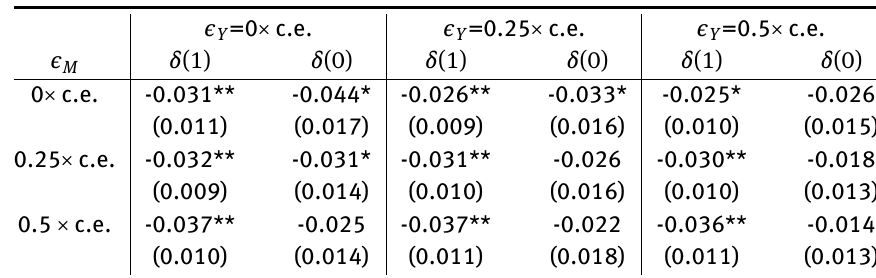
3 This is because −0.3 = −0.5 × 0.6, and the corresponding R 2 = (−0.5) 2 = 0.25, and R 2 = 0.6 2 = 0.36, respectively. 4 This is because −0.2 = −0.5 × 0.4, and the corresponding R 2 = (−0.5) 2 = 0.25, and R 2 = 0.4 2 = 0.16,